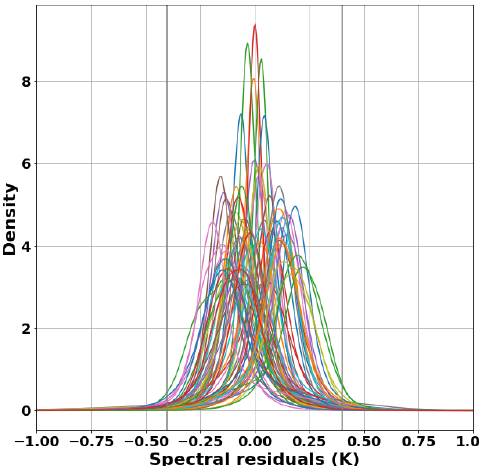
Figure 1. Density functions (absolute numbers) of spectral residuals in all selected retrieval channels, for 15 January 2018. Each channel is plotted with a different